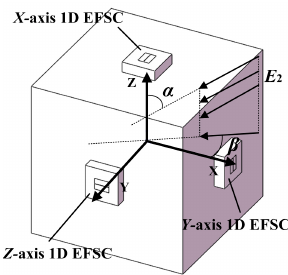
Figure 7. Simulation model for the response of the 3D EFS to a 3D electric field with different directions.